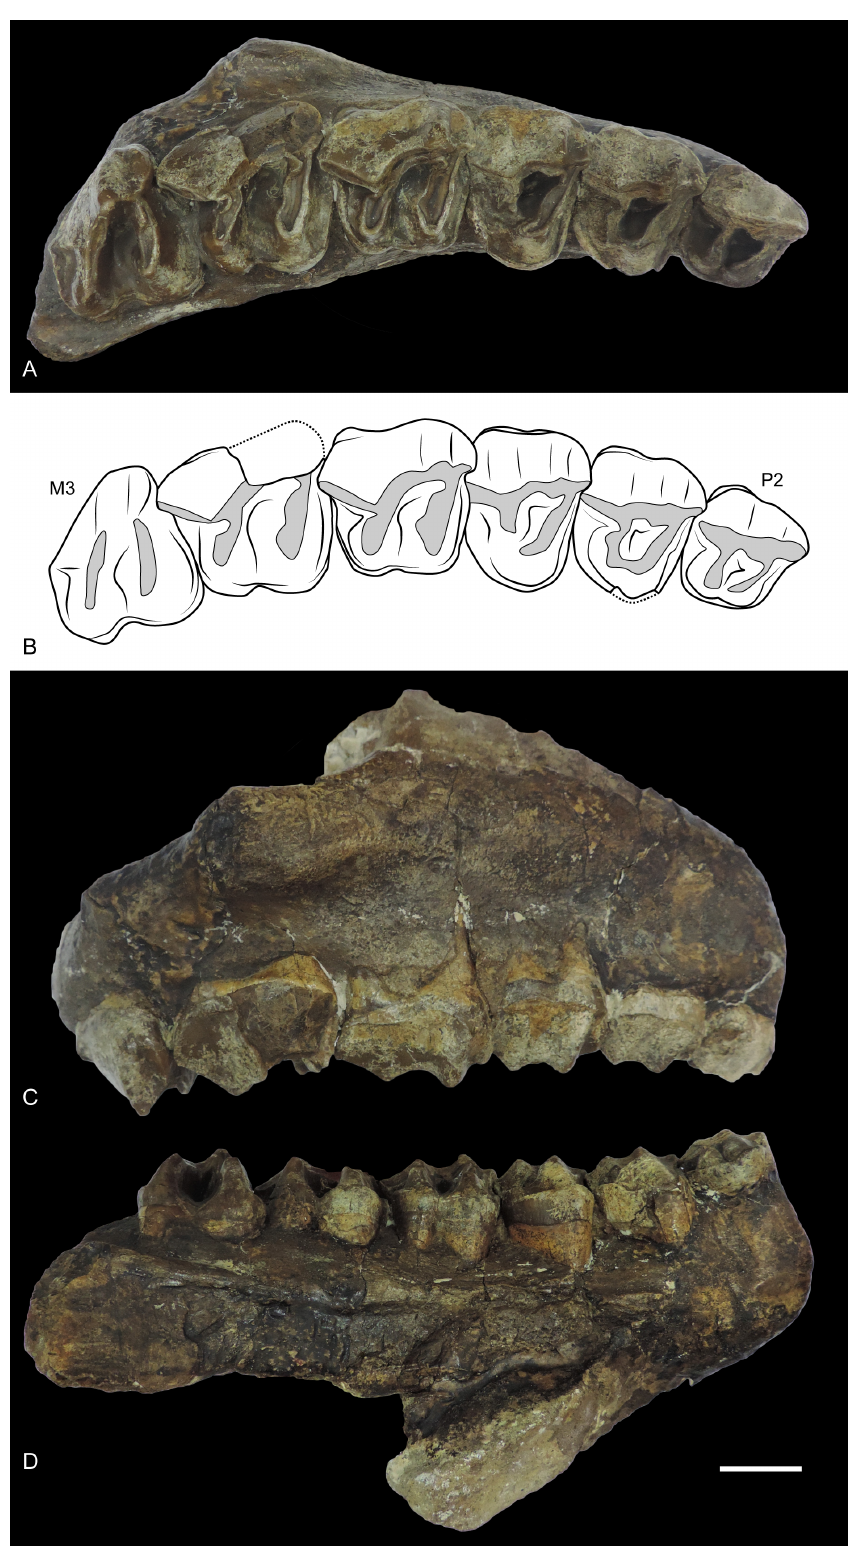
Fig. 14. Ronzotherium filholi (Osborn, 1900), senior synonym of R. kochi Kretzoi, 1940, from Valea Popii, Cluj-Napoca (earliest Oligocene, Romania). Right maxilla MBT 1509 with P2–M3. A . Occlusal view. B . Drawing of P2–M3. C . Maxilla in lateral view. D . Maxilla in medial view. Scale bar: 2